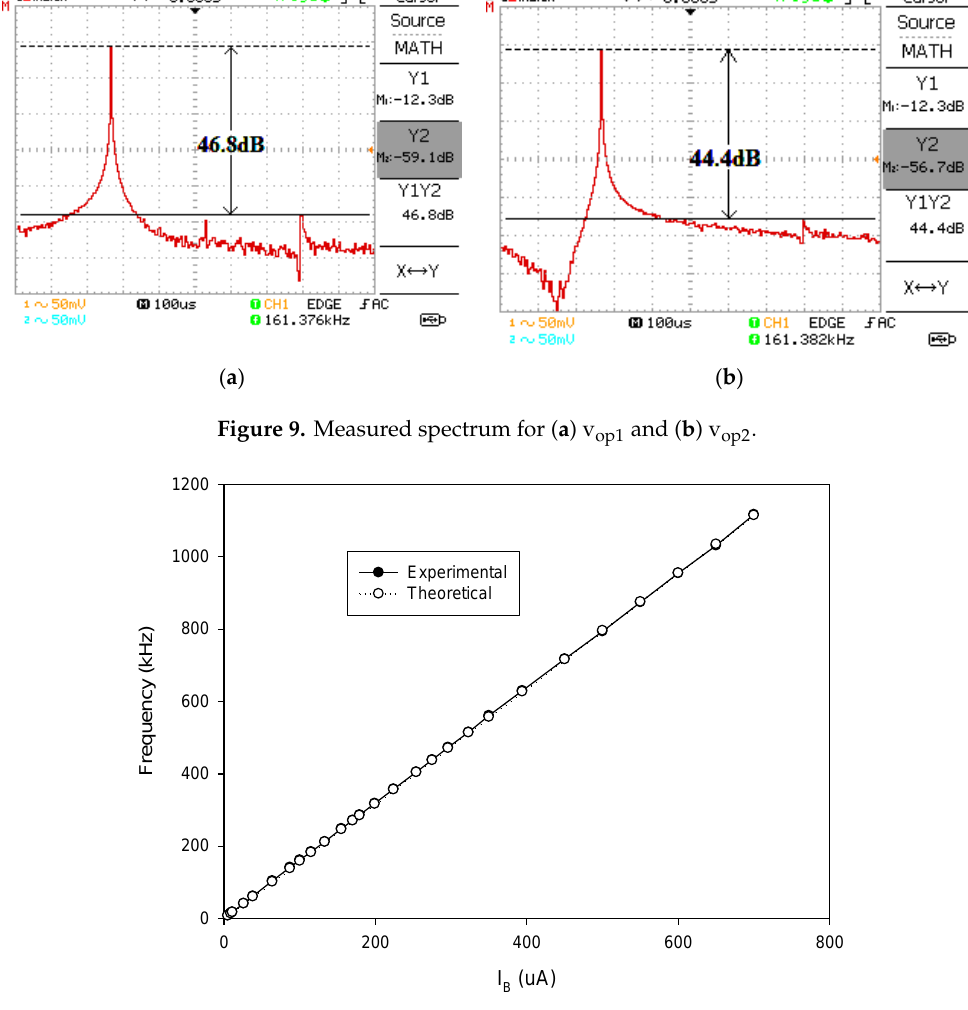
Figure 10. The plot of the frequency of oscillation vs I B (I B1 = I B2 = I B ).